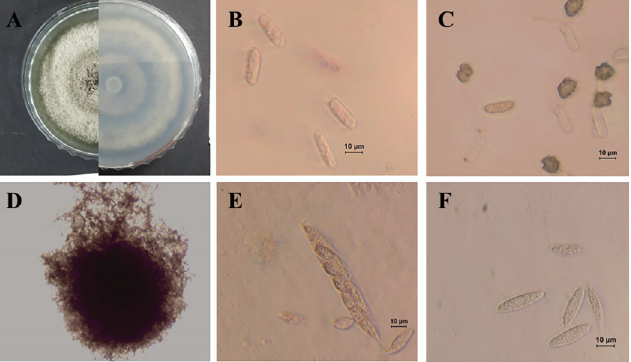
Fig 12. Morphological characteristics of C . plurivorum (isolate SPML22). A: Colony on PDA above and below. B: Conidia. C: Appressoria D: Perithecia. E: Ascus. F: Ascospore.